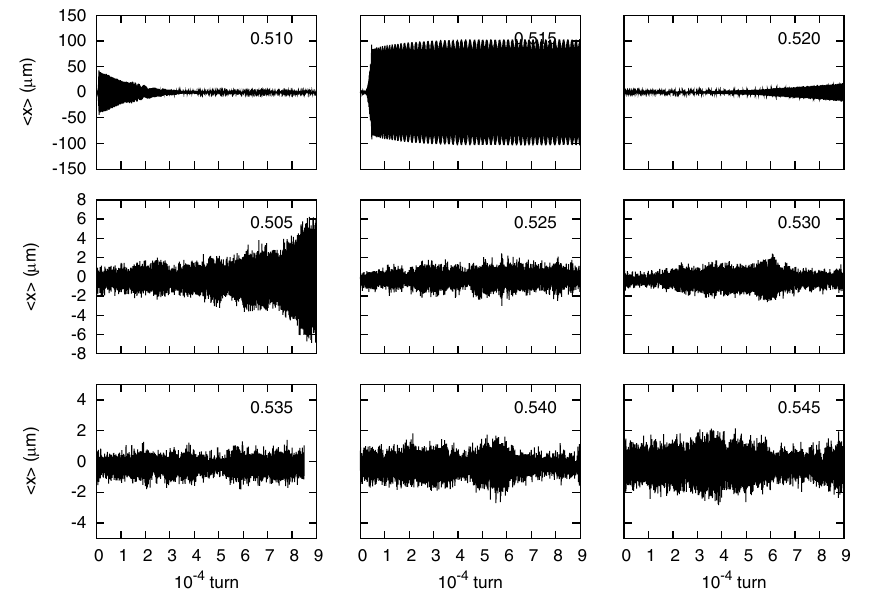
FIG. 8. Evolution of the horizontal dipole amplitude of the beam. The corresponding horizontal tune is written in each figure. The vertical tune is